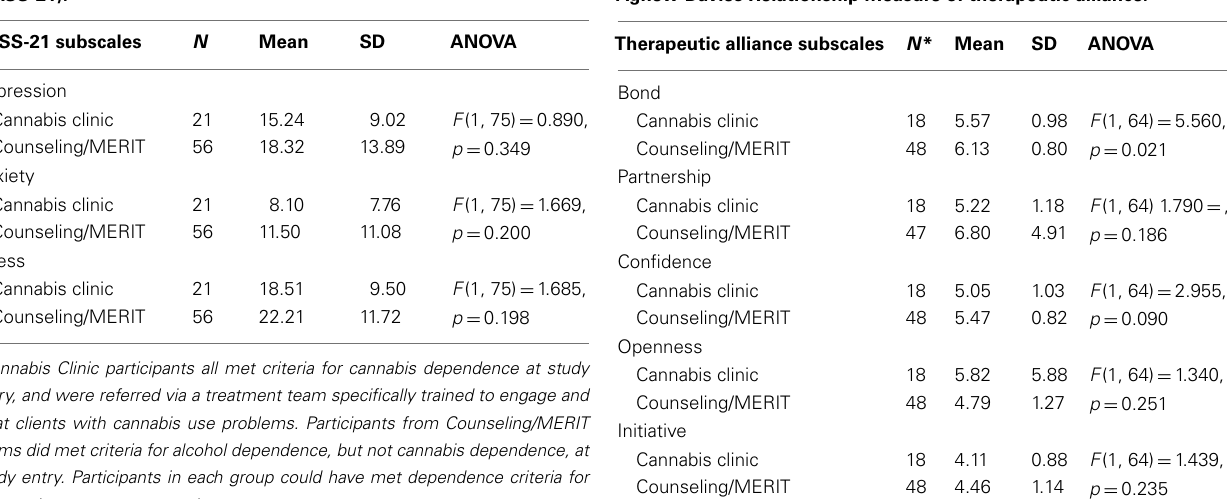
Table 5 |A comparison of Cannabis Clinic versus MERIT/Counseling Team # participants on measures of depression, anxiety, and stress (DASS-21).